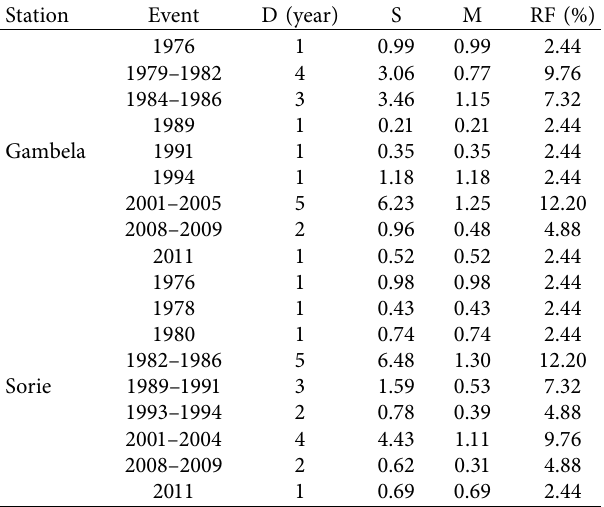
Table 10: Hydrological drought characterization in Ethiopian major river basins, Awash river